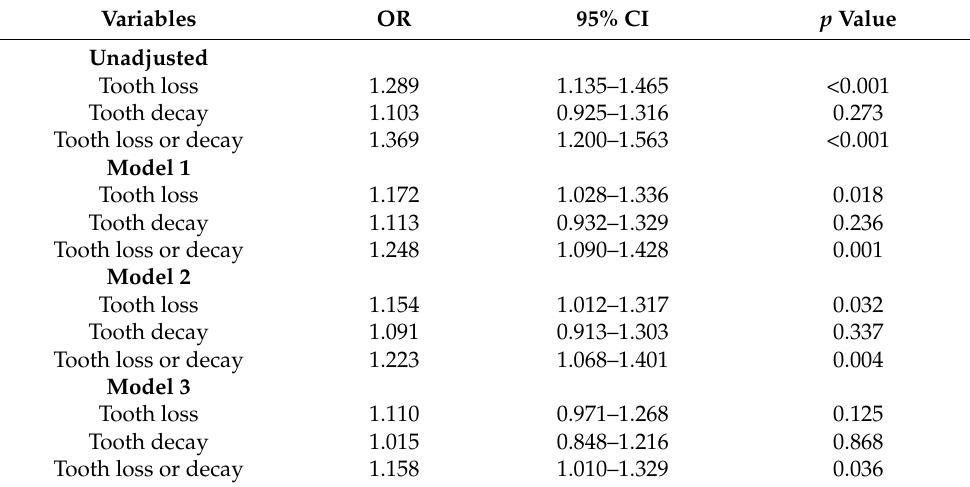
Table 2. Odds ratios for the presence of AoAC by dental diseases.